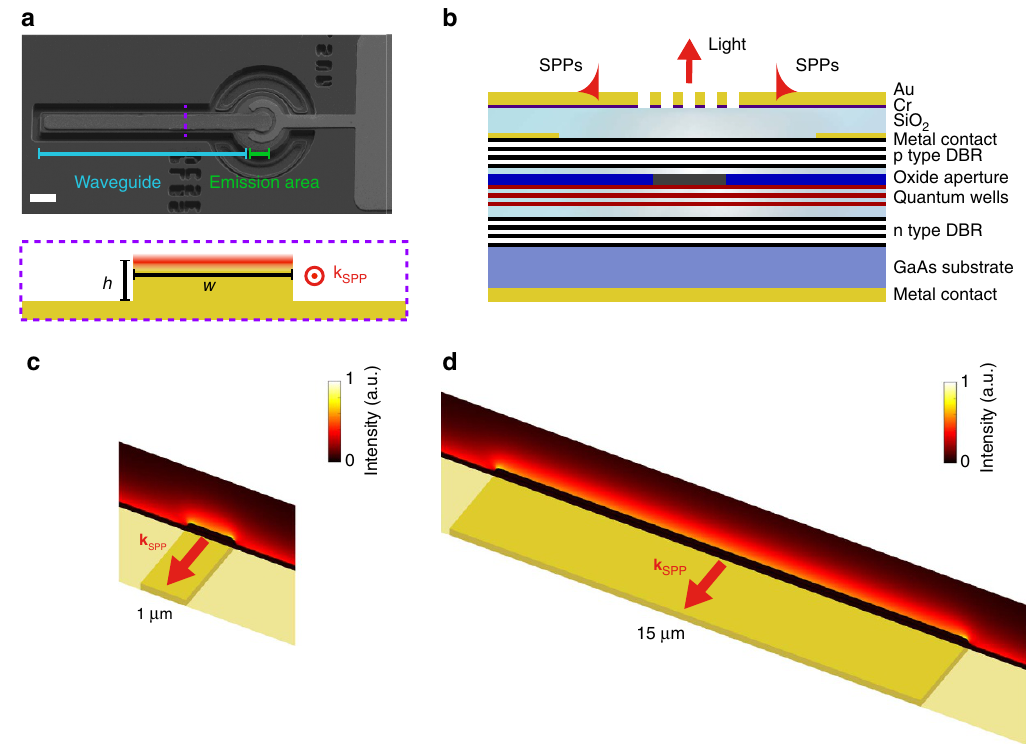
Figure 1 | Plasmonic VCSEL. ( a ) Scanning electron microscope image of a plasmonic VCSEL and a schematic of a cross-section across the stripe waveguide with width w and height h . k SPP is the SPP wavevector, directed parallel to the long axis of the waveguide. Scale bar, 20 m m. ( b ) Cross-section of a plasmonic VCSEL based on a diode emitting at a wavelength of 850nm, with an additional gold layer that supports SPP modes. The emission area, and hence SPP excitation region, is defined by the underlying position of the oxide aperture. ( c , d ) The SPP mode intensity distributions overlaid on the waveguide schematics, obtained from the eigenmode simulations for the Au stripe waveguides with ( c ) w ¼ 1 m m and ( d ) w ¼ 10 m m, where h ¼ 100nm in both cases. a.u., arbitrary